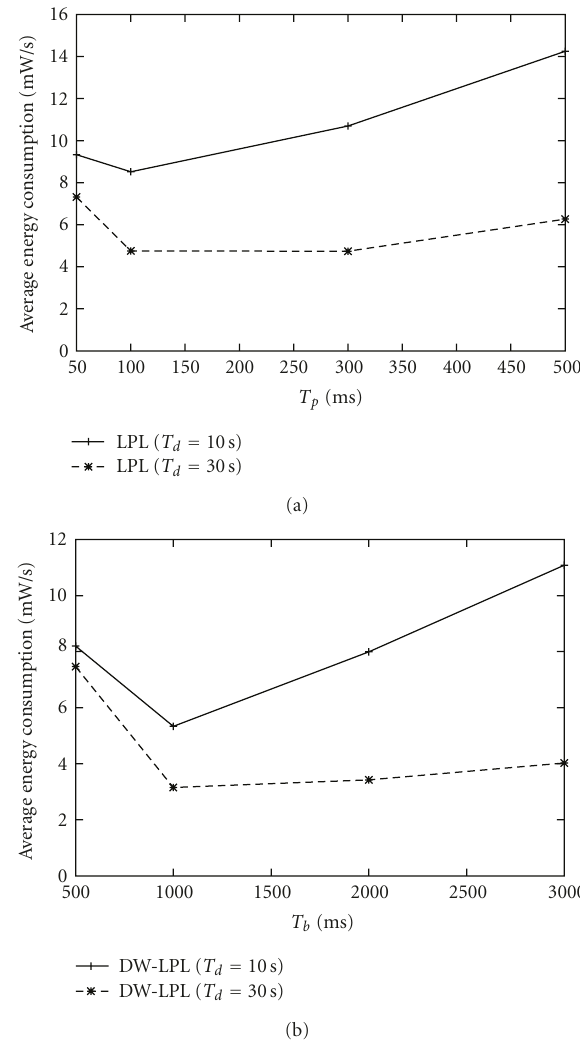
Figure 8: The experiment result for varying wake-up intervals ( n = 10): (a) LPL; (b) DW-LPL.